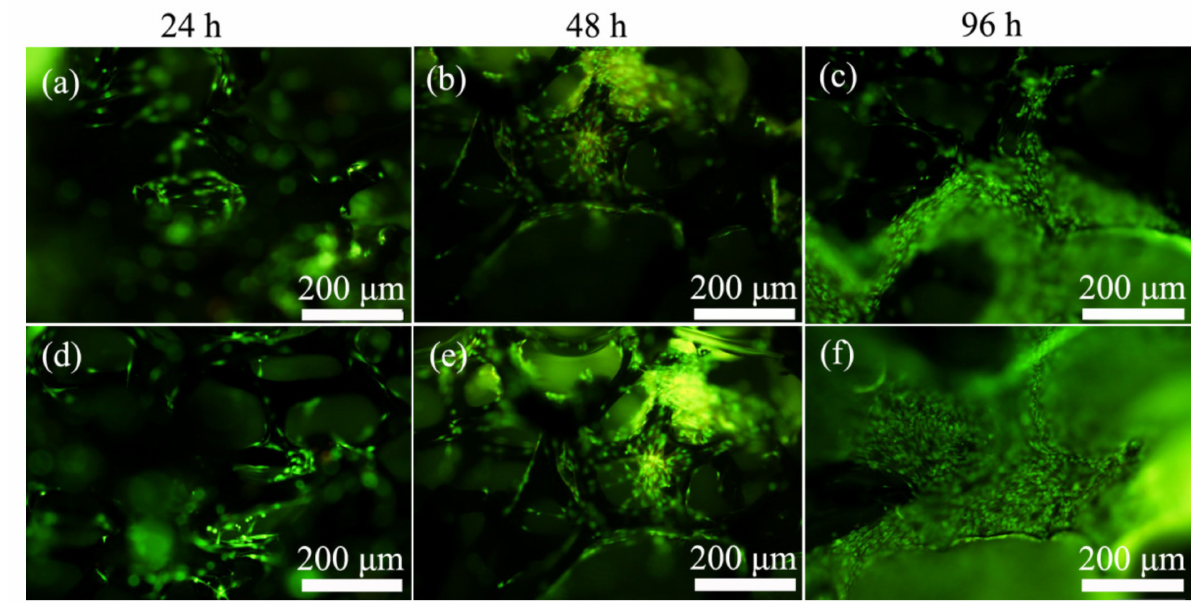
Figure 3. Fluorescence microscopy images of AO/EB double staining assay of MC3T3-E1 cells after co-culture with 3D rGO/PPY ( a – c ) and 3D rGO/PPY/Sr ( d – f ) composite scaffolds at 24, 48 and 96 h,